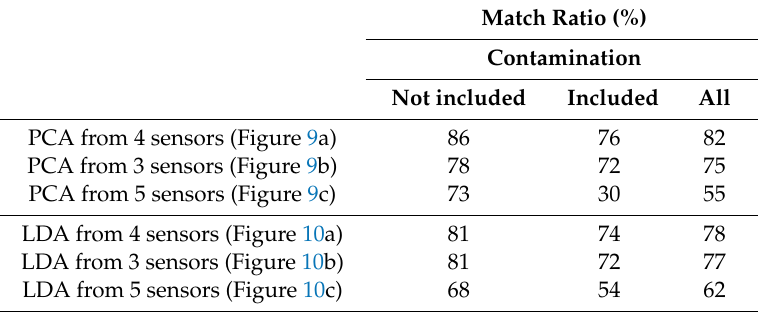
Table 5. Weighted averages of PCA and LDA match ratios from four-, three-, and five-sensor sets.